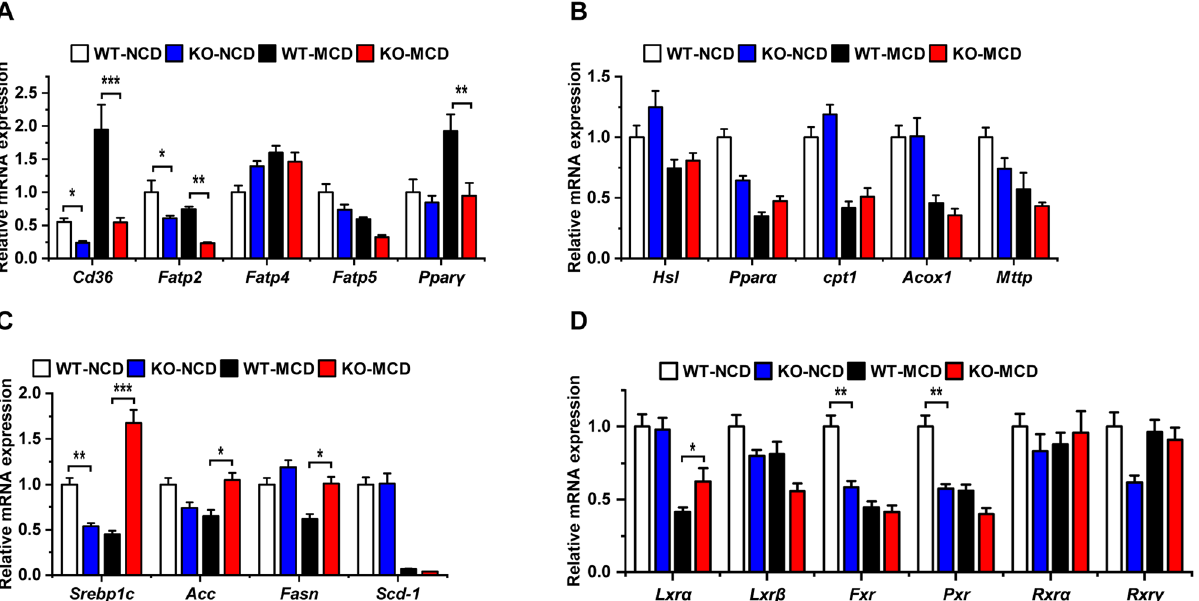
Figure 3. Lipid metabolism gene expression in liver tissues. ( A ) Fatty acid uptake gene expression. ( B ) Fatty acid oxidation gene expression. ( C ) Fatty acid synthesis gene expression. ( D ) Nuclear receptor gene expression. Each group at least has 3 samples. The data in ( A – D ) are presented as the mean ± SD, *p < 0.05; **p < 0.01, and ***p <